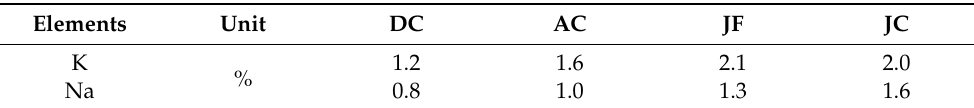
Table 2. Potassium and sodium content before and after bio-oxidation for samples AC and DC. 95% Confidence Interval.